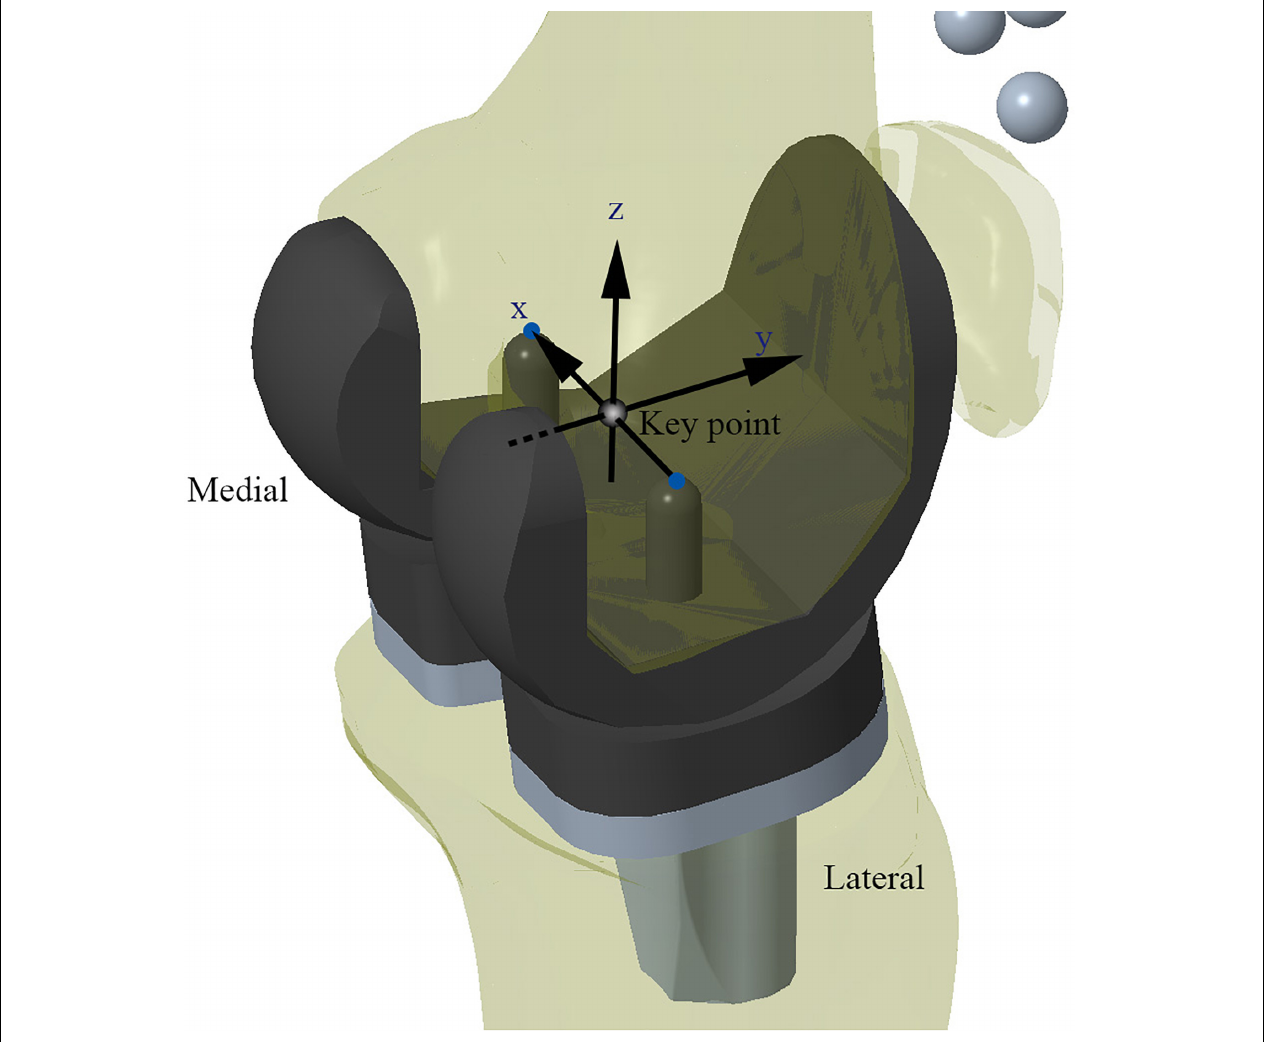
FIGURE 3 | Schematic diagram of the Model 1 for validation. Kinematic data recorded from the “Key point” marker was used for model